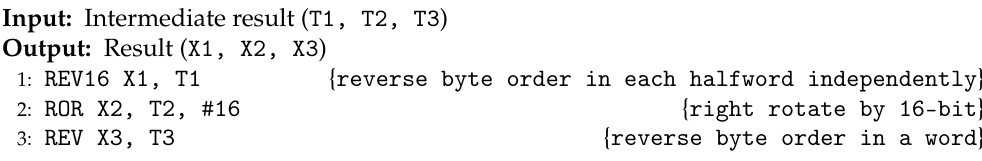
Algorithm 6 P layer of ARIA block cipher on the ARM Cortex-M3